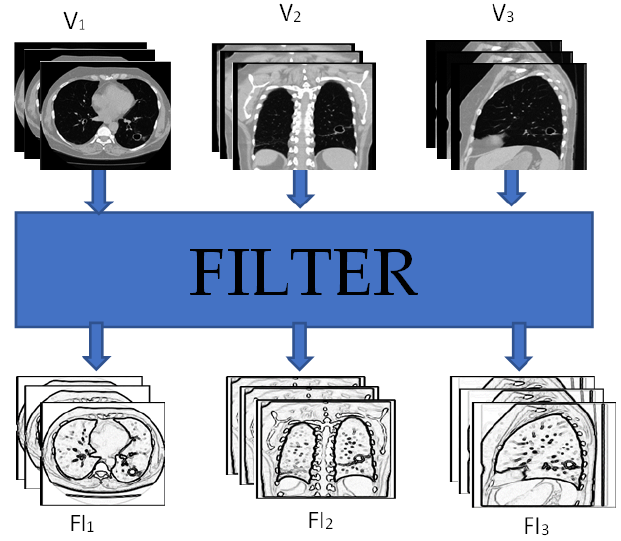
Figure 6. Feature images are created by filtering the slices from each perspective.